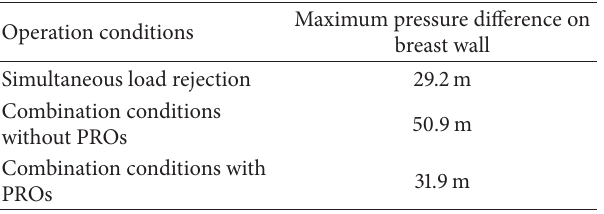
Table 1: Comparisons between simultaneous and successive load rejection.